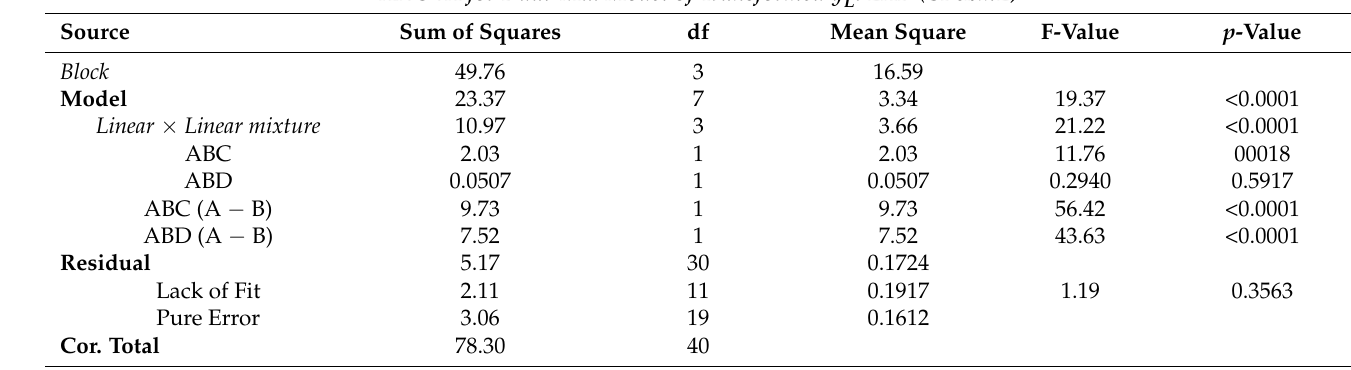
Table 2. ANOVA for dual-mix L-optimal R.S.M. on the transformed responses of LAB (upper), Yeast (middle) and Acceptability